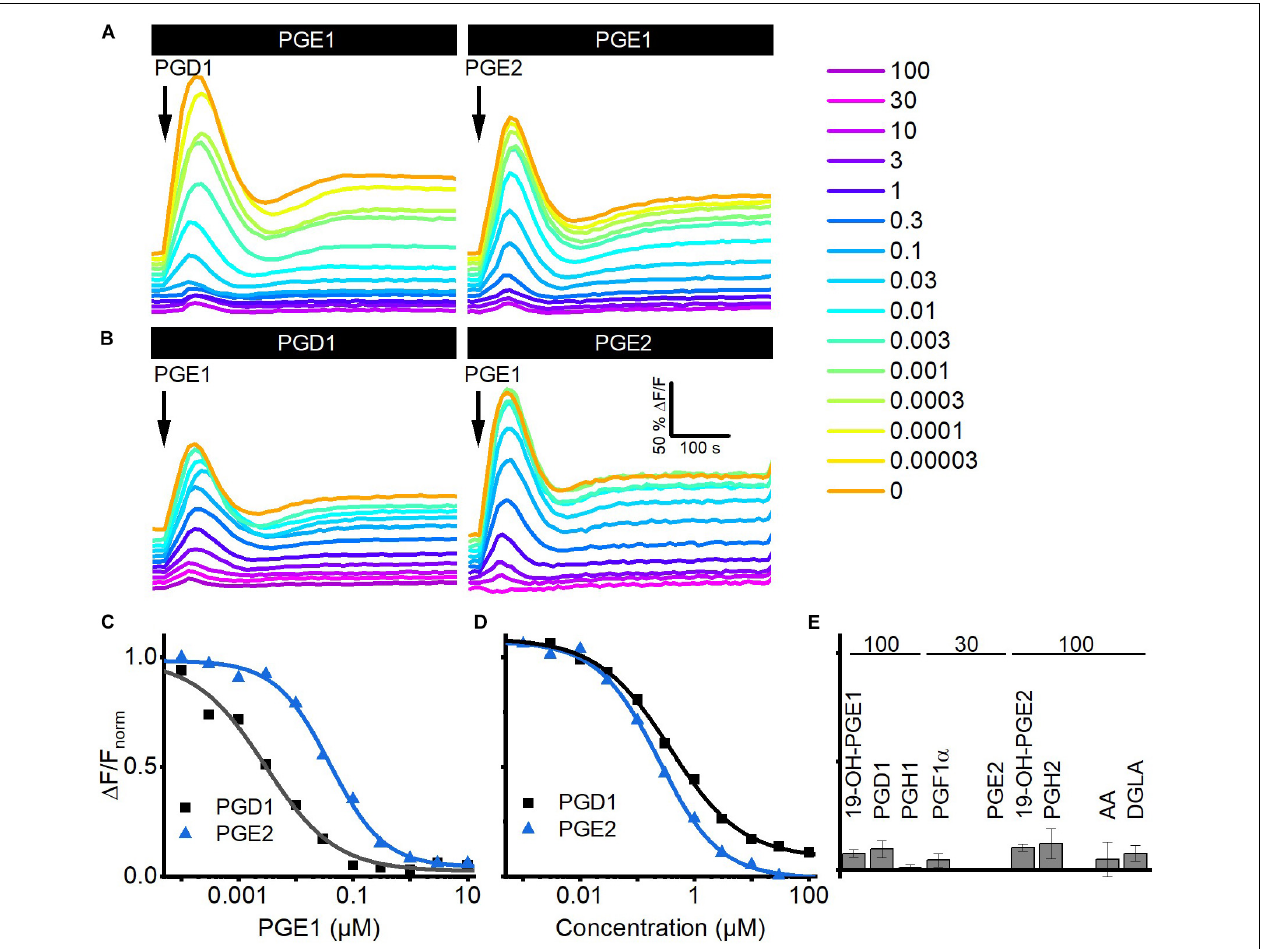
FIGURE 5 | Prostaglandins compete for the same binding site to activate CatSper in human sperm. (A) Representative Ca 2 + signals evoked by a saturating concentration of PGD 1 (100 µ M) and PGE 2 (30 µ M) in sperm preincubated in different concentrations of PGE 1 . (B) Representative Ca 2 + signals evoked by a saturating concentration of PGE 1 (3 µ M) in sperm preincubated in different concentrations of PGD 1 or PGE 2 . (C) Maximal amplitude of PGD 1 - and PGE 2 -evoked Ca 2 + responses shown in (A) , plotted as a function of the (preincubated) PGE 1 concentration. (D) Maximal amplitude of the PGE 1 -evoked Ca 2 + responses shown in (B) , plotted as a function of the (preincubated) PGD 1 or PGE 2 concentration. (E) Mean ( ± SD) maximal amplitude of PGE 1 -evoked Ca 2 + signals in sperm preincubated in the indicated (in µ M) saturating concentrations of the respective prostaglandin ( n =